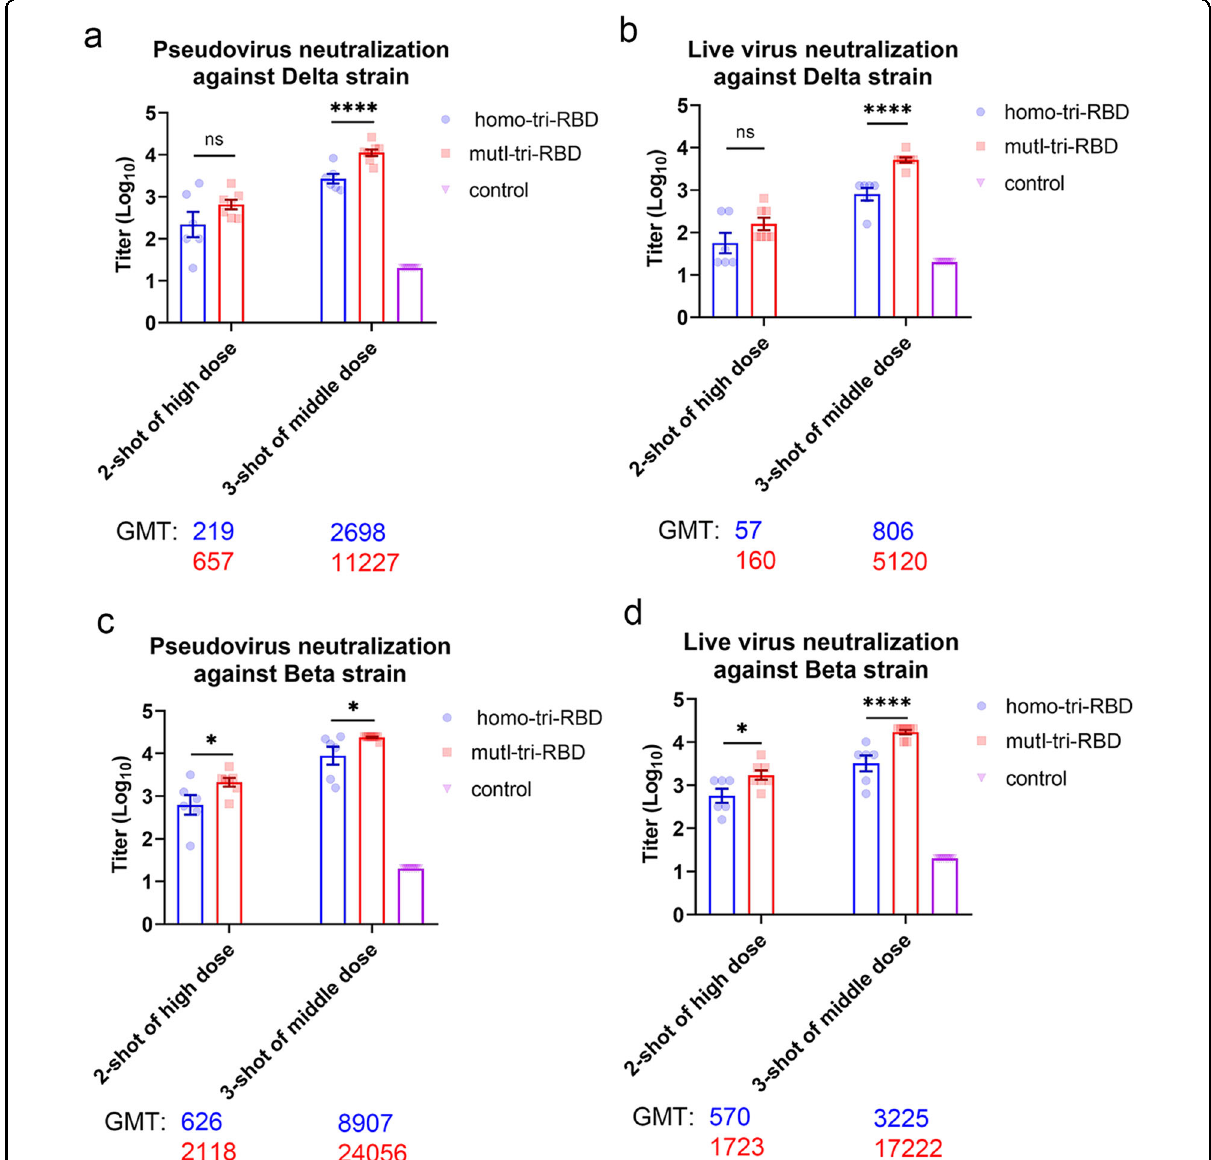
Fig. 3 mutI-tri-RBD induced signi fi cantly higher titer of neutralizing antibody responses against the Delta and Beta variants compared with homo-tri-RBD. a , b The pseudo-virus ( a ) and live-virus ( b ) neutralizing antibody titers against the SARS-CoV-2 Delta variant induced by mutI-tri- RBD in the sera collected on day 7 post-immunization (D28 in Fig. 2a) were distinctly higher than those elicited by homo-tri-RBD. c , d The pseudo- virus ( c ) and live-virus ( d ) neutralizing antibody titers against SARS-CoV-2 Beta variant induced by mutI-tri-RBD were also obviously higher than those elicited by homo-tri-RBD. Data are presented as means ± SEM. P values were calculated by using one-way ANOVA followed by Sidak ’ s multiple comparison test. * P < 0.05, **** P < 0.001, ns, not signi fi